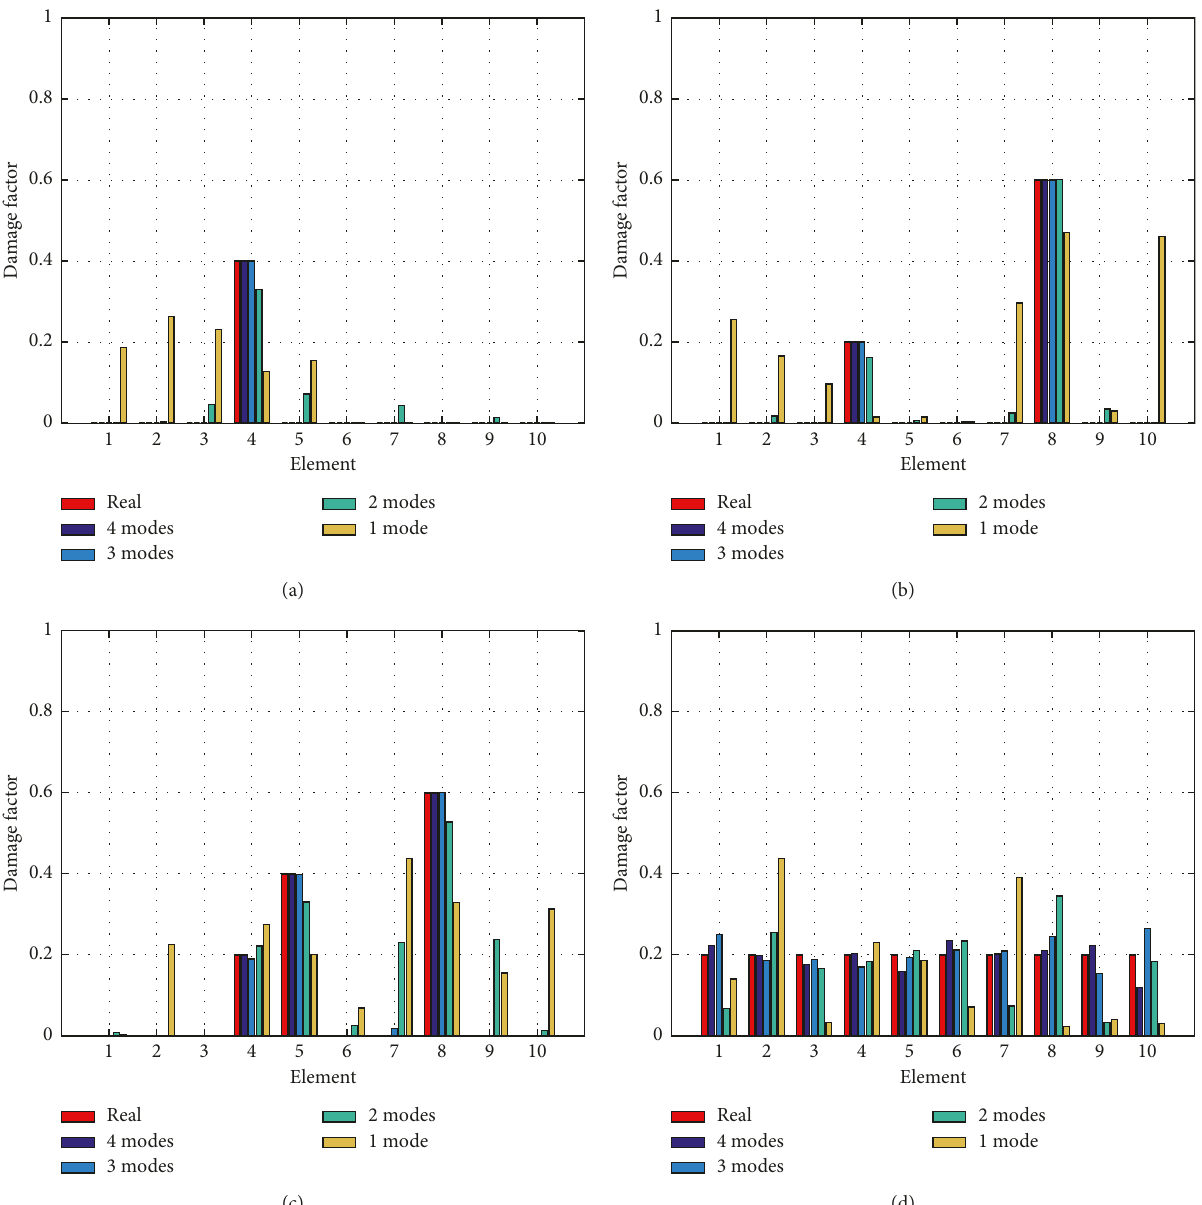
Figure 7: Beam example: performance of the combined criterion for different damage scenarios (noise 5%). (a) Scenario 1, (b) scenario 2, (c) scenario 3, and (d) scenario 4. Table 2: Beam example: norm values for different damage scenarios and 1 to 4 known modes (noise 5%). Known